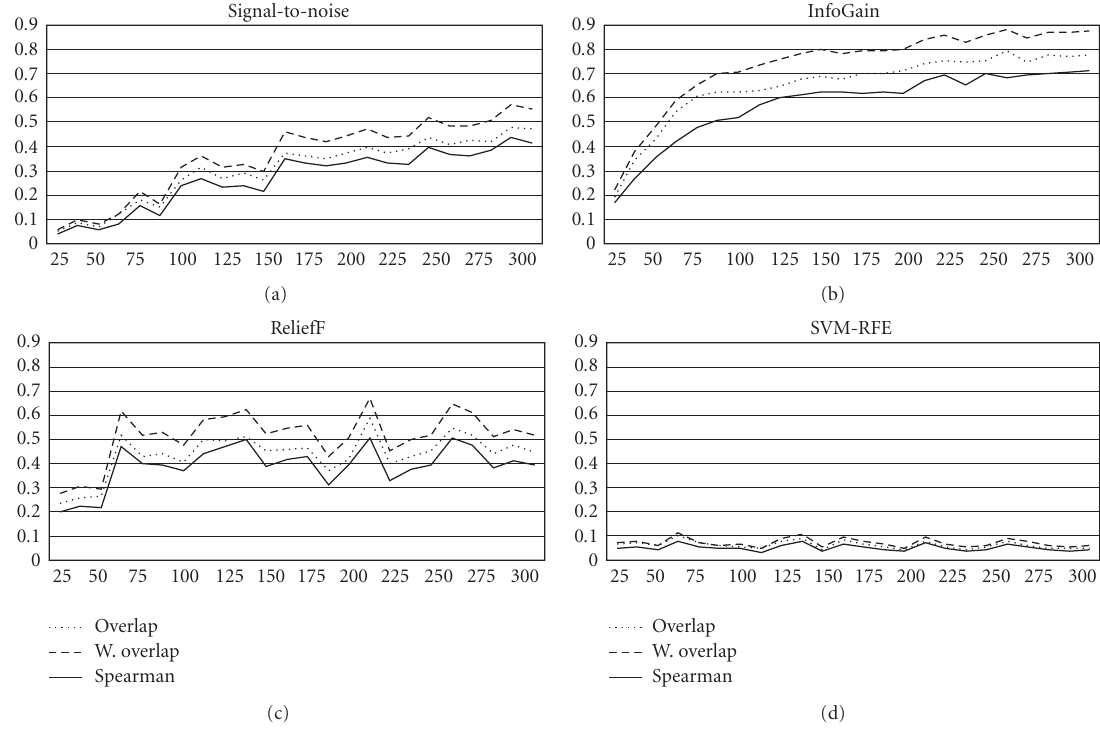
Figure 2: Relation between number of samples and stability using partitioning technique (breast versus colon cancer dataset).